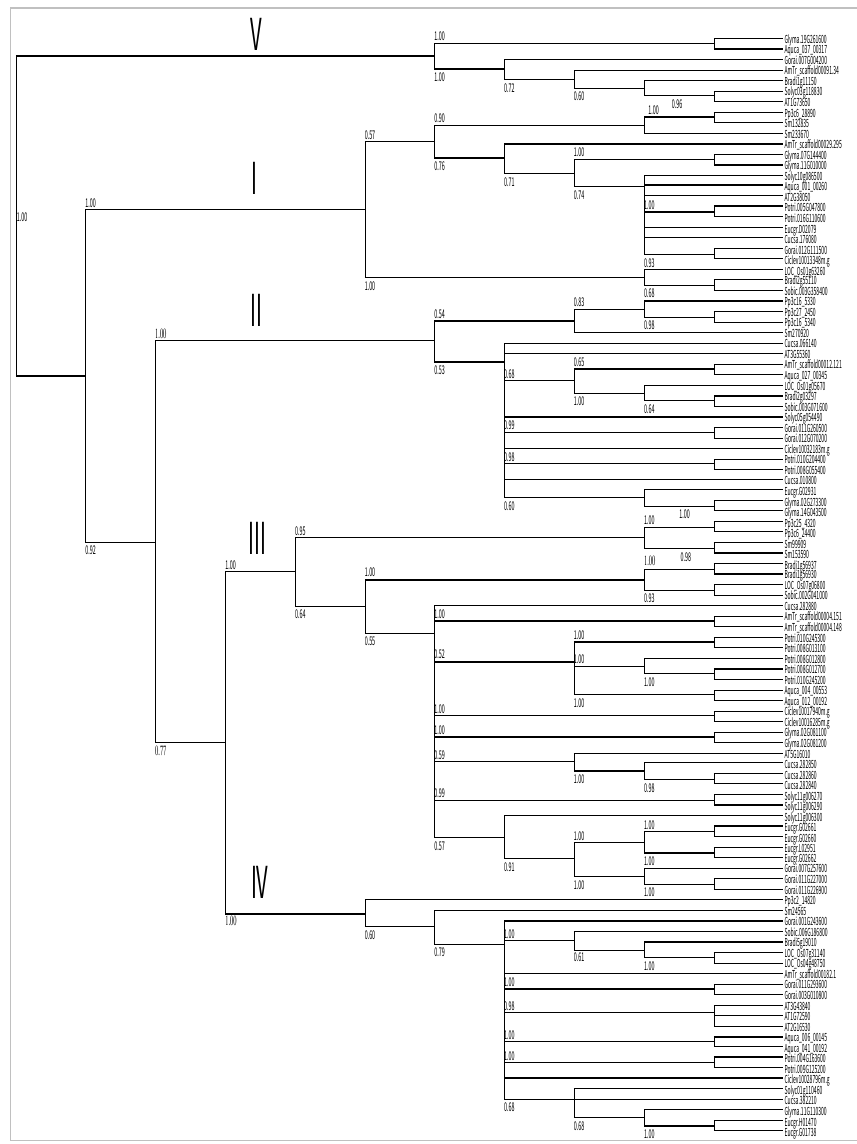
Figure 3. Molecular phylogenetic analysis of steroid reductases in planta. BLASTP was used to search for BR receptor homologues in different plant species. A total of 105 steroid reductase as shown in Additional File 1 (Spreadsheet S1) was analyzed from Physcomitrella patens (Pp), Selaginella moellendorffii (Sm), Cucumis sativus (Cucsa), Populus trichocarpa (Potri), Eucalyptus grandis (Eucgr), Citrus clementina (Cicle), Solanum lycopersicum (Solyc), Glycine max (Glyma), Arabidopsis thaliana (AT), Brachypodium distachyon (Bradi), Oryza sativa (Os), Amborella trichopoda (AmTr), Gossypium raimondii (Gorai), Aquilegia coerulea (Aqcoe) and Sorghum bicolor (Sobic). Values expressed below the branches are the probability of the bootstrap value with 1000 repeats. MrBayes 3.2 [43] software was used to reconstruct the phylogenetic tree, as described in the Methods